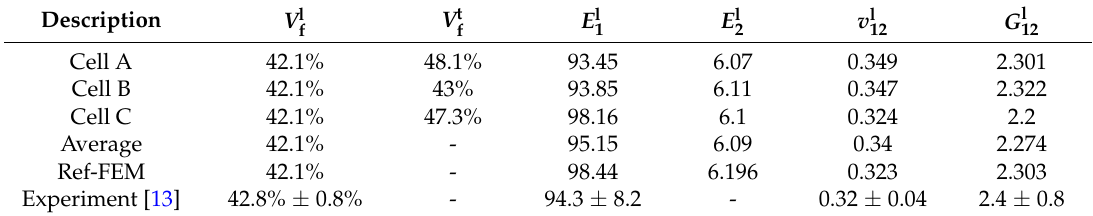
Table 6. In-plane stiffness of the NCF (non-crimp fabric) lamina obtained with mesomechanical analysis procedure